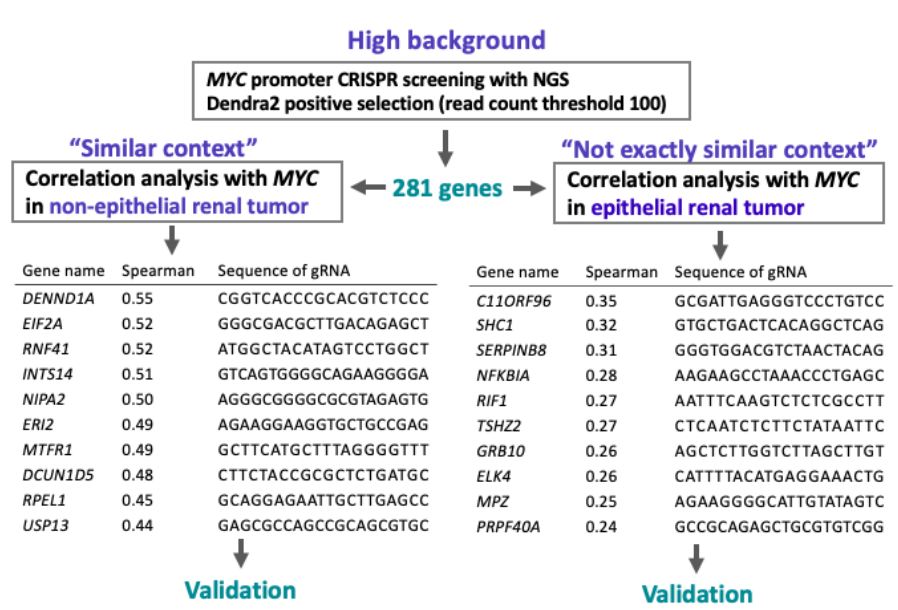
Figure 1. Modified MYC transcriptional activator screening and context-matched database screening. ( A ) Modified MYC transcriptional activator screening [16] ( B ) Schematic of the pipeline for screening.